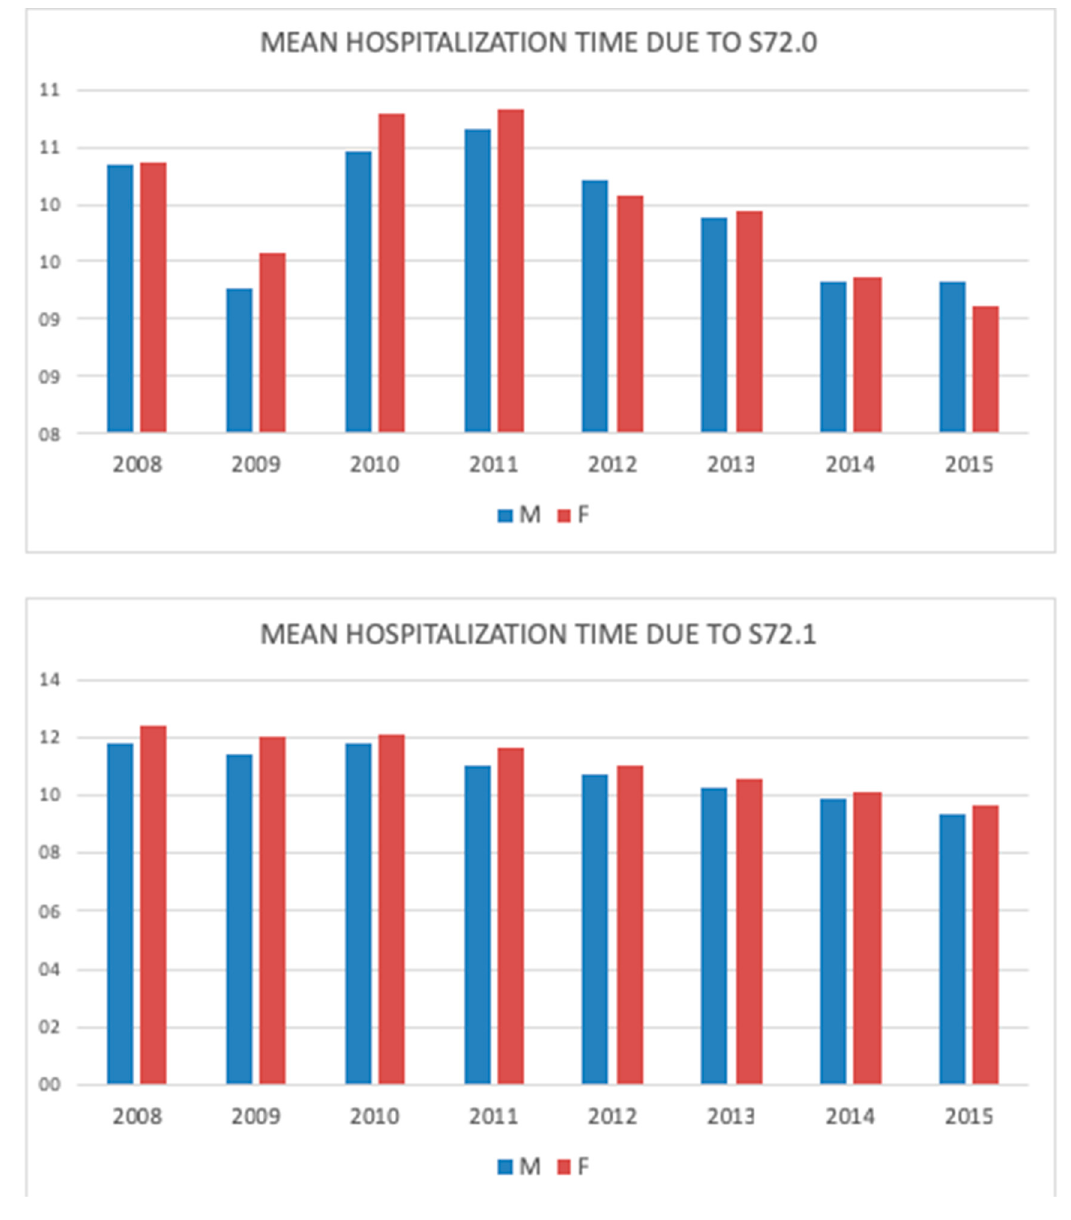
Figure 7. Mean hospitalization time due to the femoral neck (S72.0) and pertrochanteric fracture (S72.1) in men and women during the study period (2008–2015).